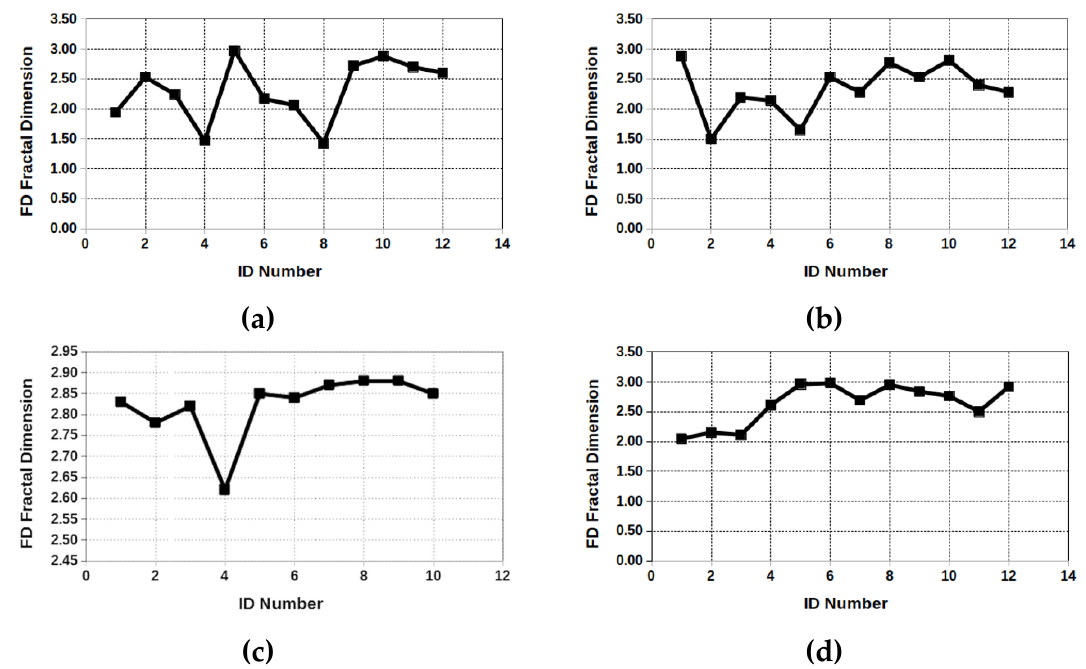
Figure 5. Fractal dimension (FD) values found in different planes in four spatial directions. ( a ) FD values in the horizontal plane. ( b ) FD values in the vertical plane. ( c ) FD values in the 45° plane. ( d ) FD values in the 135° plane.